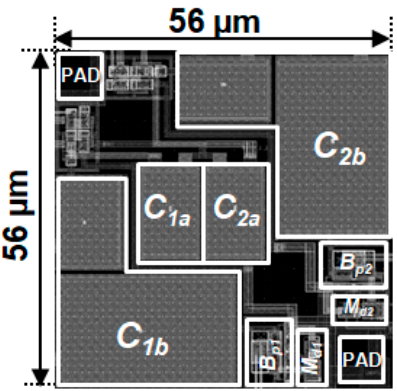
Figure 5. Mask layout of the proposed unit pixel in a 56 µm pitch.